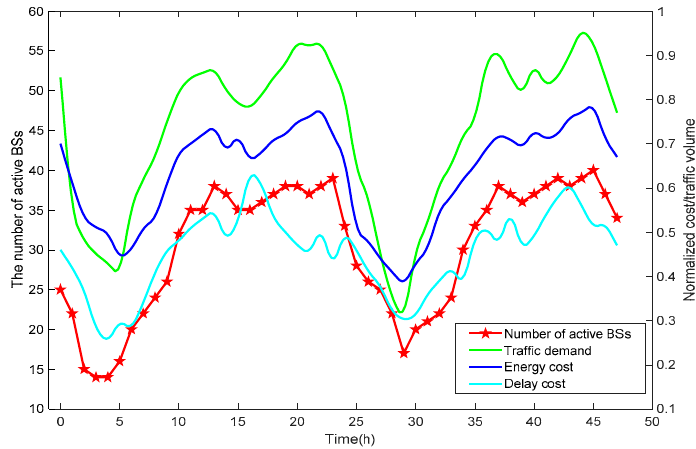
Figure 13. Network Performance of BS-off-UA scheme.